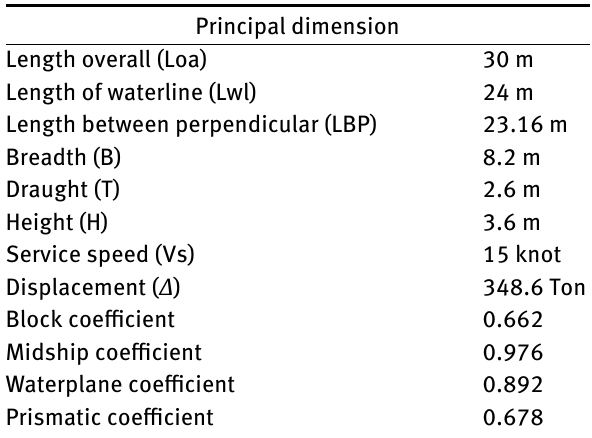
Table 4: The principal dimension of Batang type traditional purse seine vessels